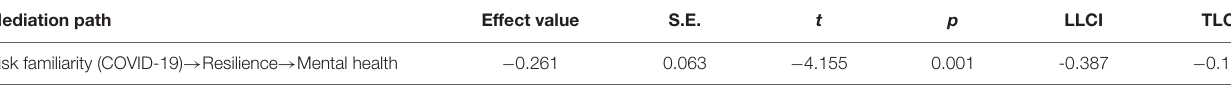
TABLE 3 | Analysis of the mediating effect of resilience between risk familiarity (COVID-19) and mental health. Mediation path